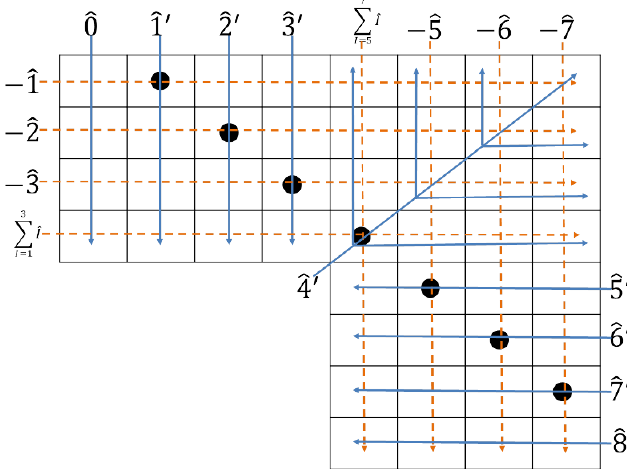
Figure 5 . This (cid:12)gure represents a picturial way to solve equation (4.6) and (cid:12)nd the mass and R-charges of all the hypermultiplets.